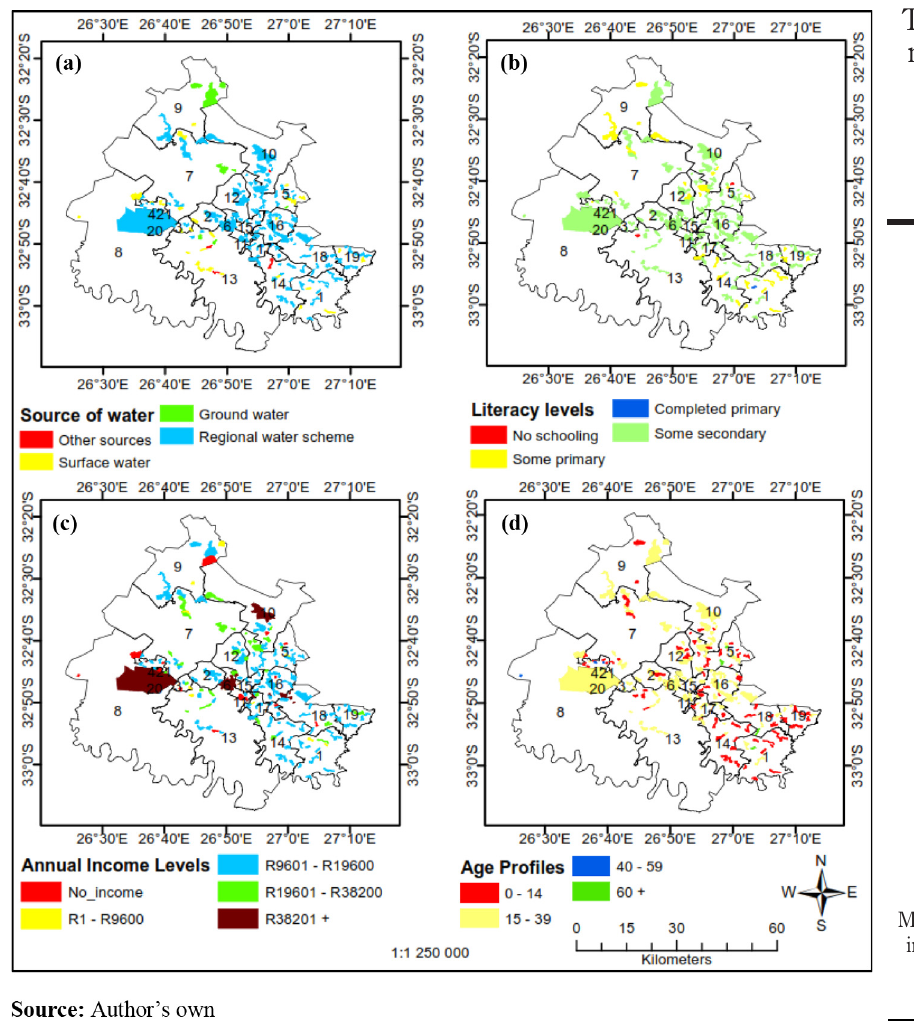
Figure 2. Maps produced from indicators that were used to assess adaptive